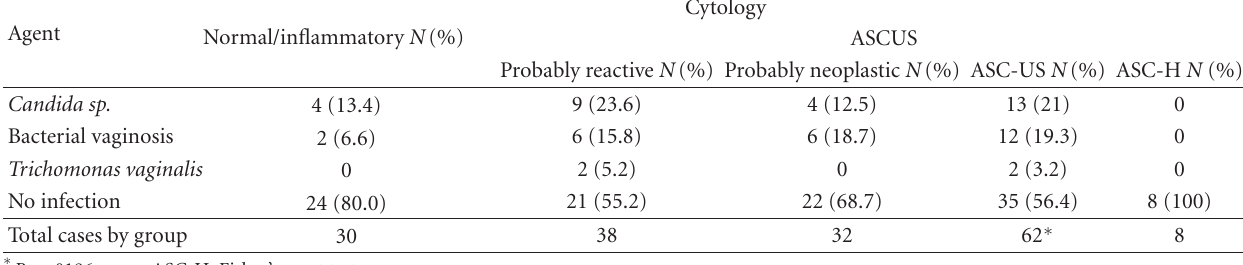
Table 1: Distribution of patients with an initial diagnosis of ASCUS which, upon review, were reclassified as normal/inflammatory, ASCUS of a probably reactive nature, and ASCUS of a probably neoplastic nature, in relation to infection.